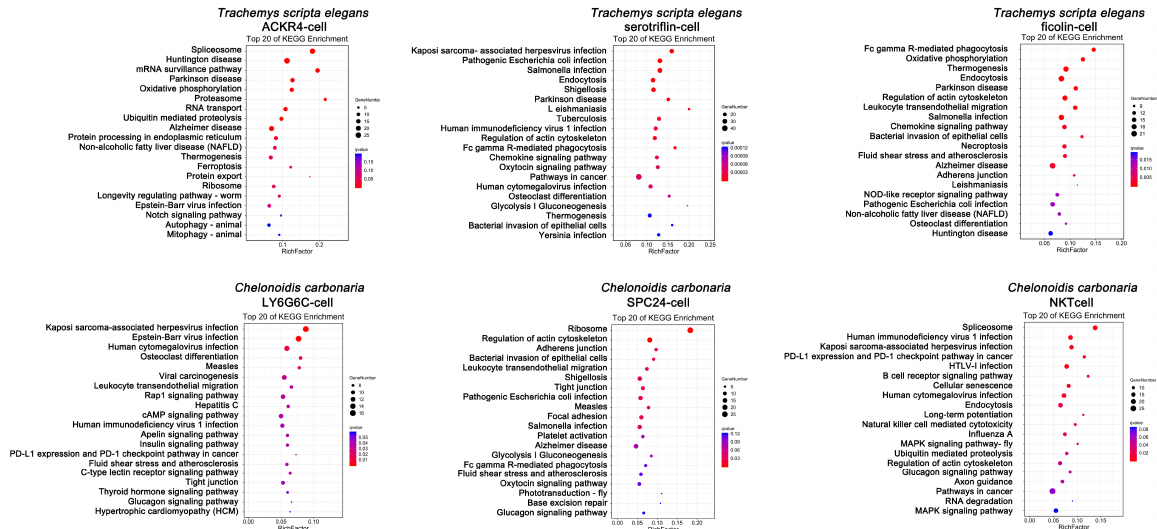
Figure 6. KEGG enrichment analysis of newly identified peripheral immune cells in